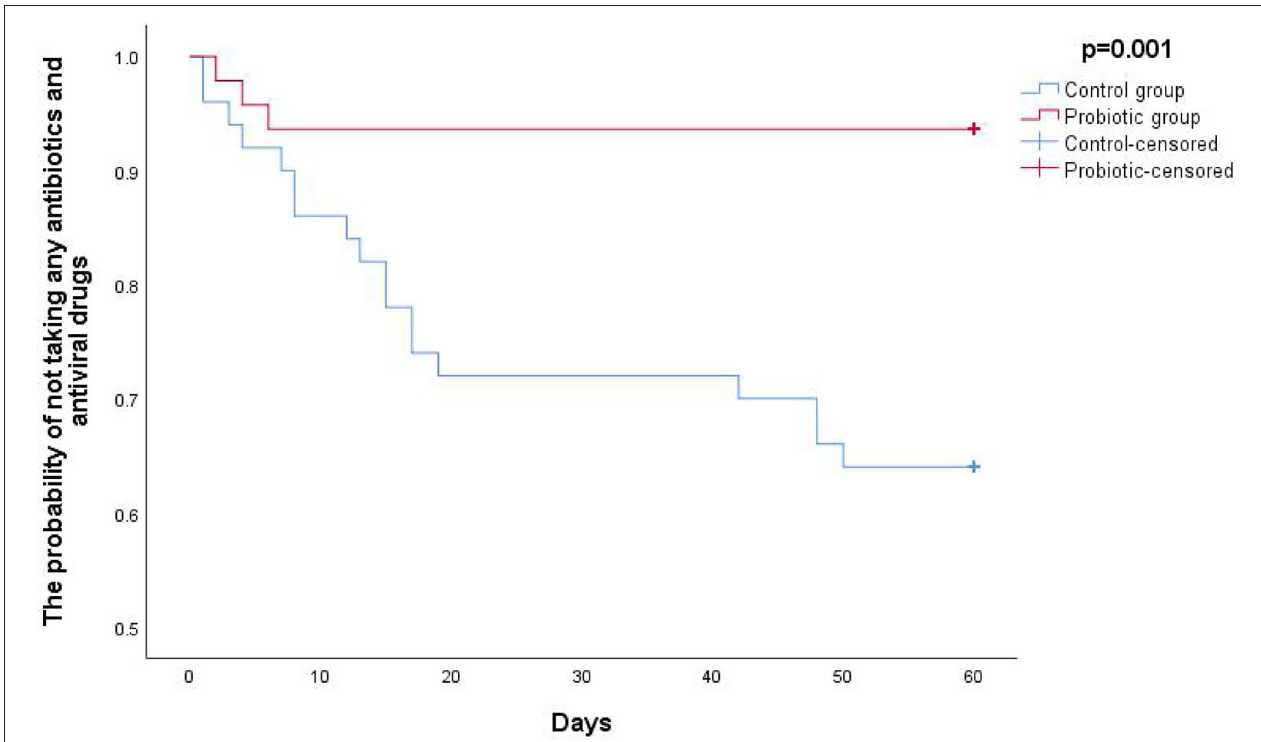
FIGURE 2 | The Kaplan–Meier curve of probability of not taking any antibiotics and antiviral drugs.